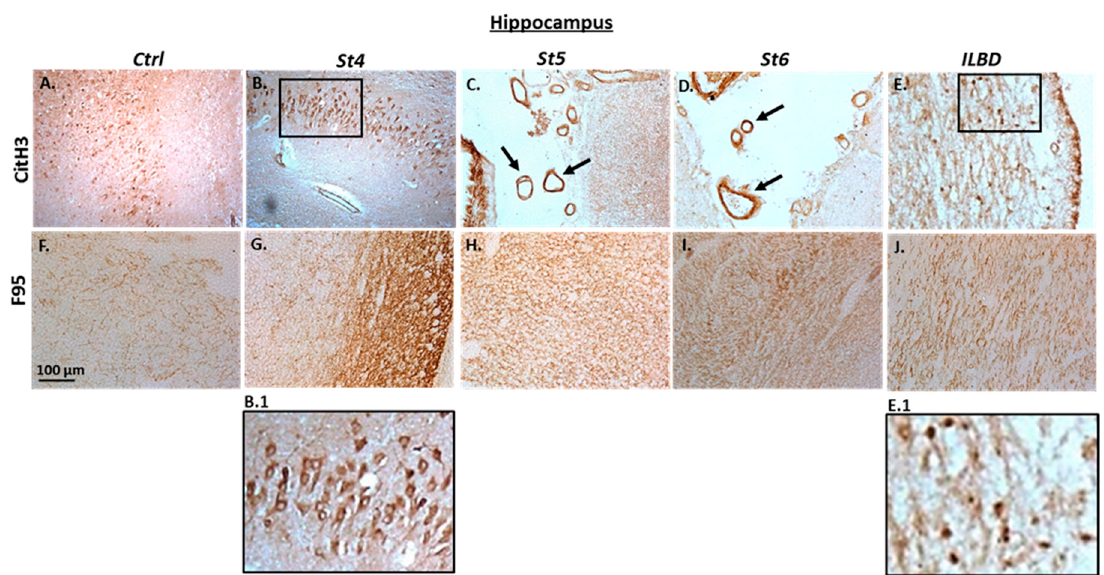
Figure 4. ( A – H ) Post-mortem human brain tissue sections of hippocampus, showing neuronal cy- toplasmic immunohistochemical detection of histone H3 deimination (CitH3) and pan-deimination (F95). PD brains at Braak stages 4, 5 and 6, as well as hippocampus with incidental Lewy body disease (ILBD) are shown, alongside control hippocampus (Ctrl). Scale bar represents 100 μ m. The black rectangles in ( B , E ) are magnified in B.1 and E.1, respectively; black arrows point at positively stained brain vasculature.